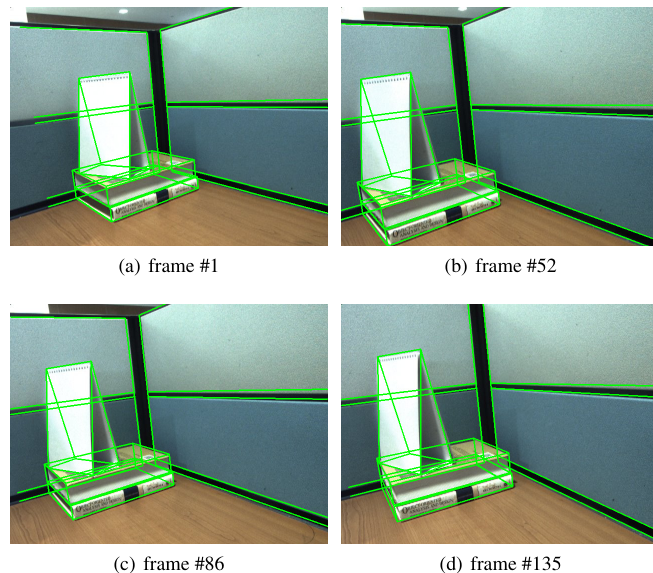
Figure 6: Pose estimation for 3D object tracking on a sequnce recorded with a moving